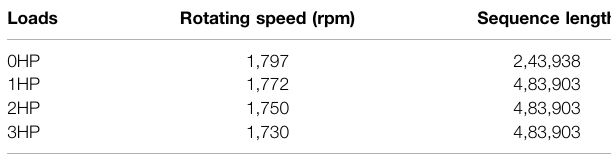
TABLE 1 | Data set attributes.